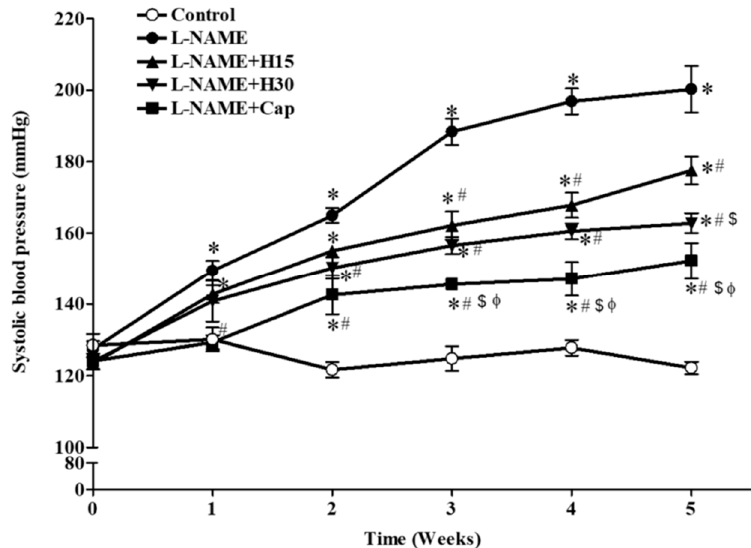
Figure 1. Time-course changes in systolic blood pressures of all experimental groups. Data are expressed as mean ± S.E.M ( n = 7–8/group), * p < 0.05 vs. control, # p < 0.05 vs. L -NAME, $ p < 0.05 vs. L -NAME + hesperidin (15 mg/kg), ɸ p < 0.05 vs. L -NAME + hesperidin (30 mg/kg) group.